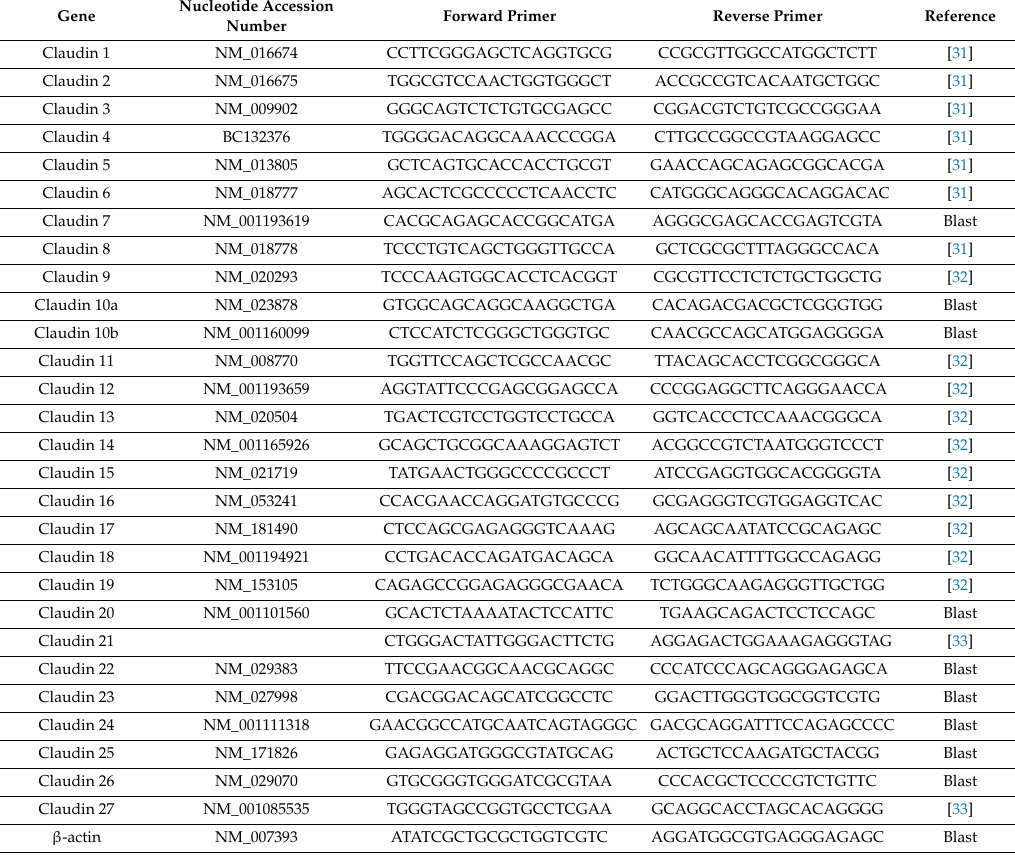
Table 2. List of primers used for murine intestine claudin expression experiments. Primer sequences used were either published sequences or designed by Dr Rajagopal. The compiled list was kindly supply by Professor A Yu of the University of Kansas Medical